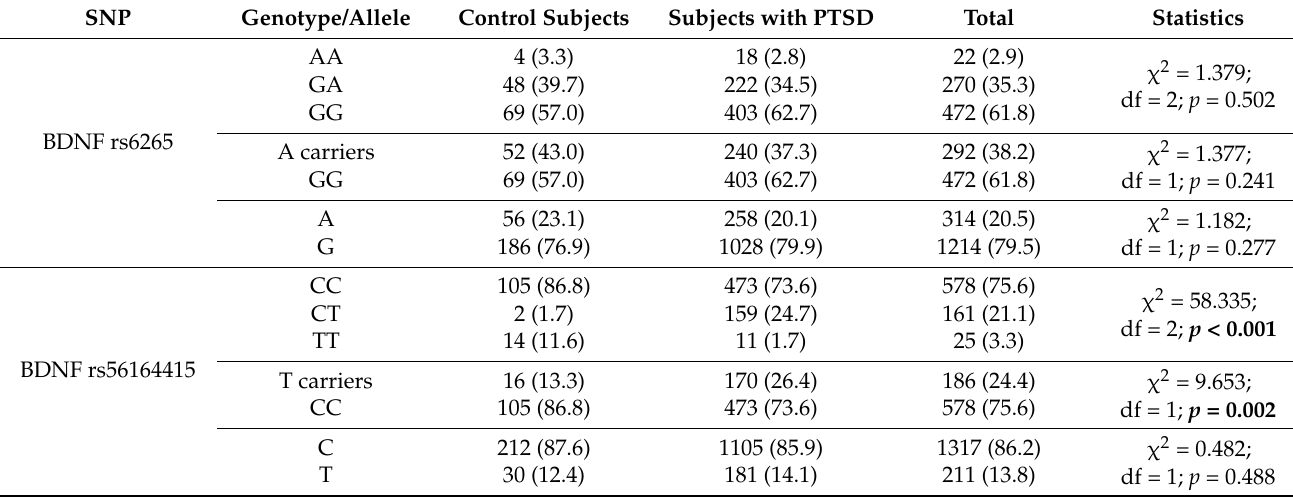
Table 2. The frequencies of the BDNF rs6265 and BDNF rs56164415 genotypes and alleles in 643 veterans with PTSD and 121 control subjects. The data is shown as total number N (frequency in percentages). p values in bold represent statistical